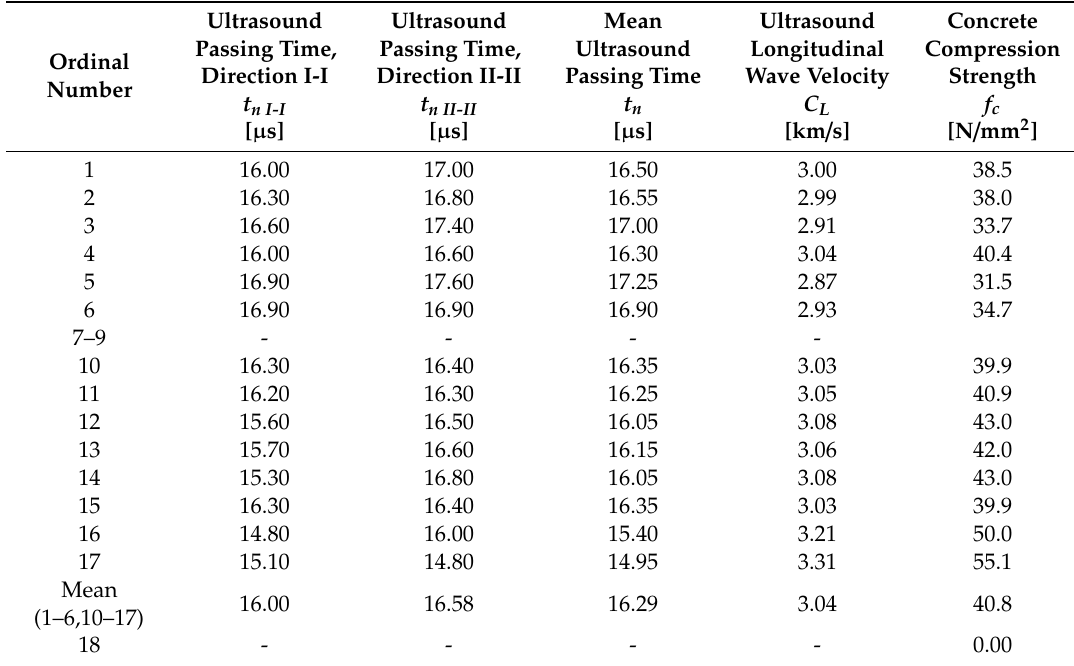
Table 5. Results of concrete compression strength test in borehole No. 3.